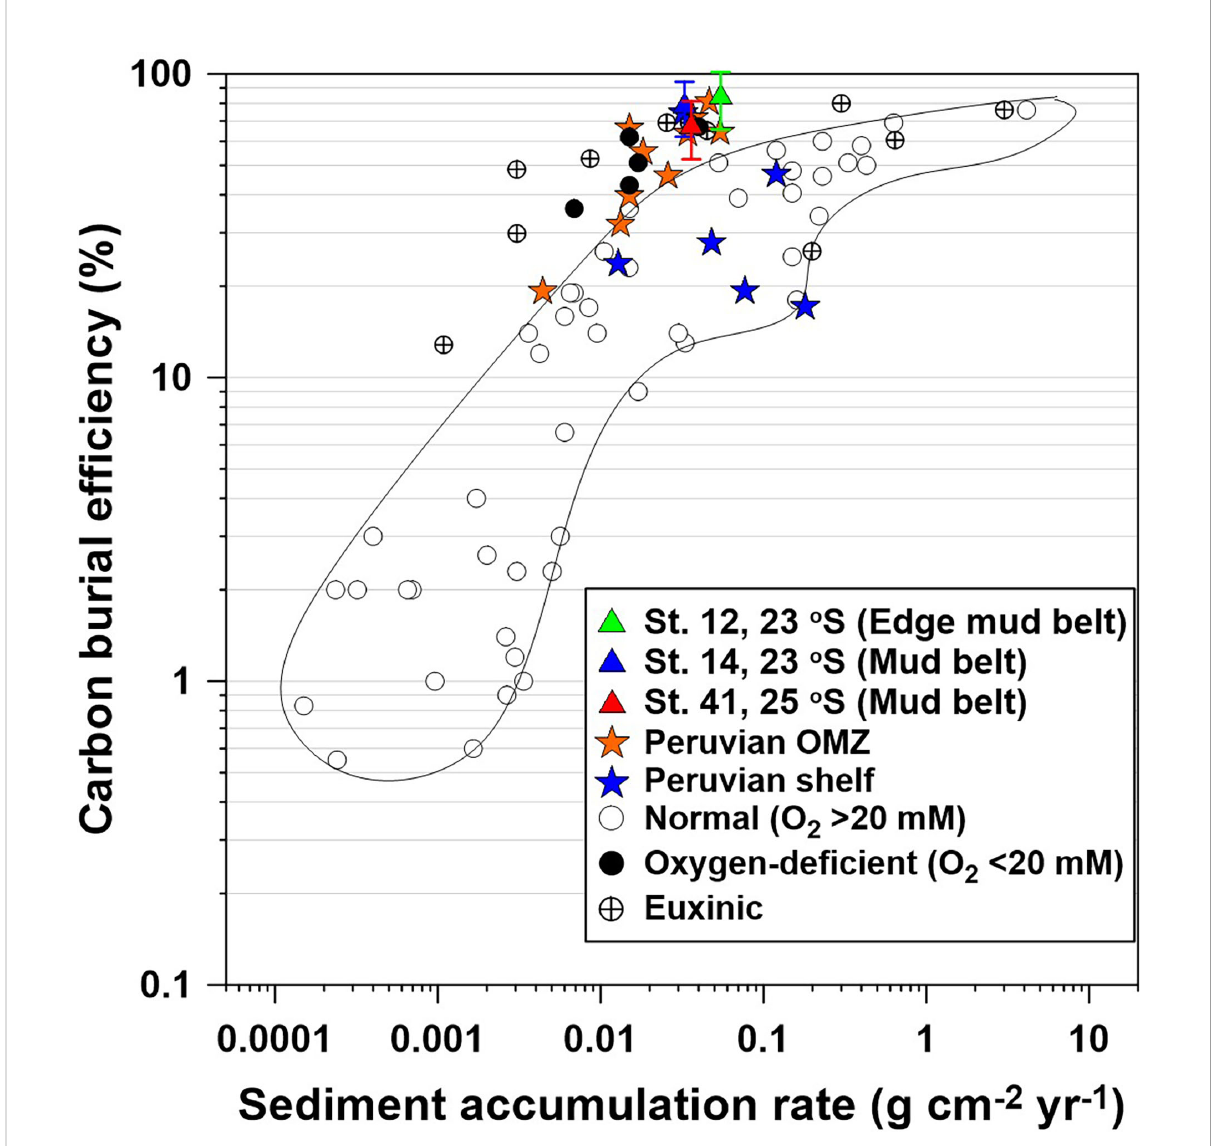
FIGURE 7 Carbon burial ef fi ciency (CBE) versus sediment accumulation rate in contemporary ocean sediments. Blue and orange stars indicate CBE at 10 cm depth for the shelf sites of the Peruvian margin (from Dale et al., 2015). Open and fi lled circles represent sites from published studies with bottom water O 2 >20 and<20 m M, respectively; the former is enclosed by the solid line. Euxinic settings are also indicated (see Dale et al. (2015) for data sources). Green, blue, and red triangles are data from this study for CBE calculated at 10 cm depth (see text). Error bars were calculated using standard error propagation rules assuming a 20% uncertainty in w acc and particulate organic carbon (POC) content at 10